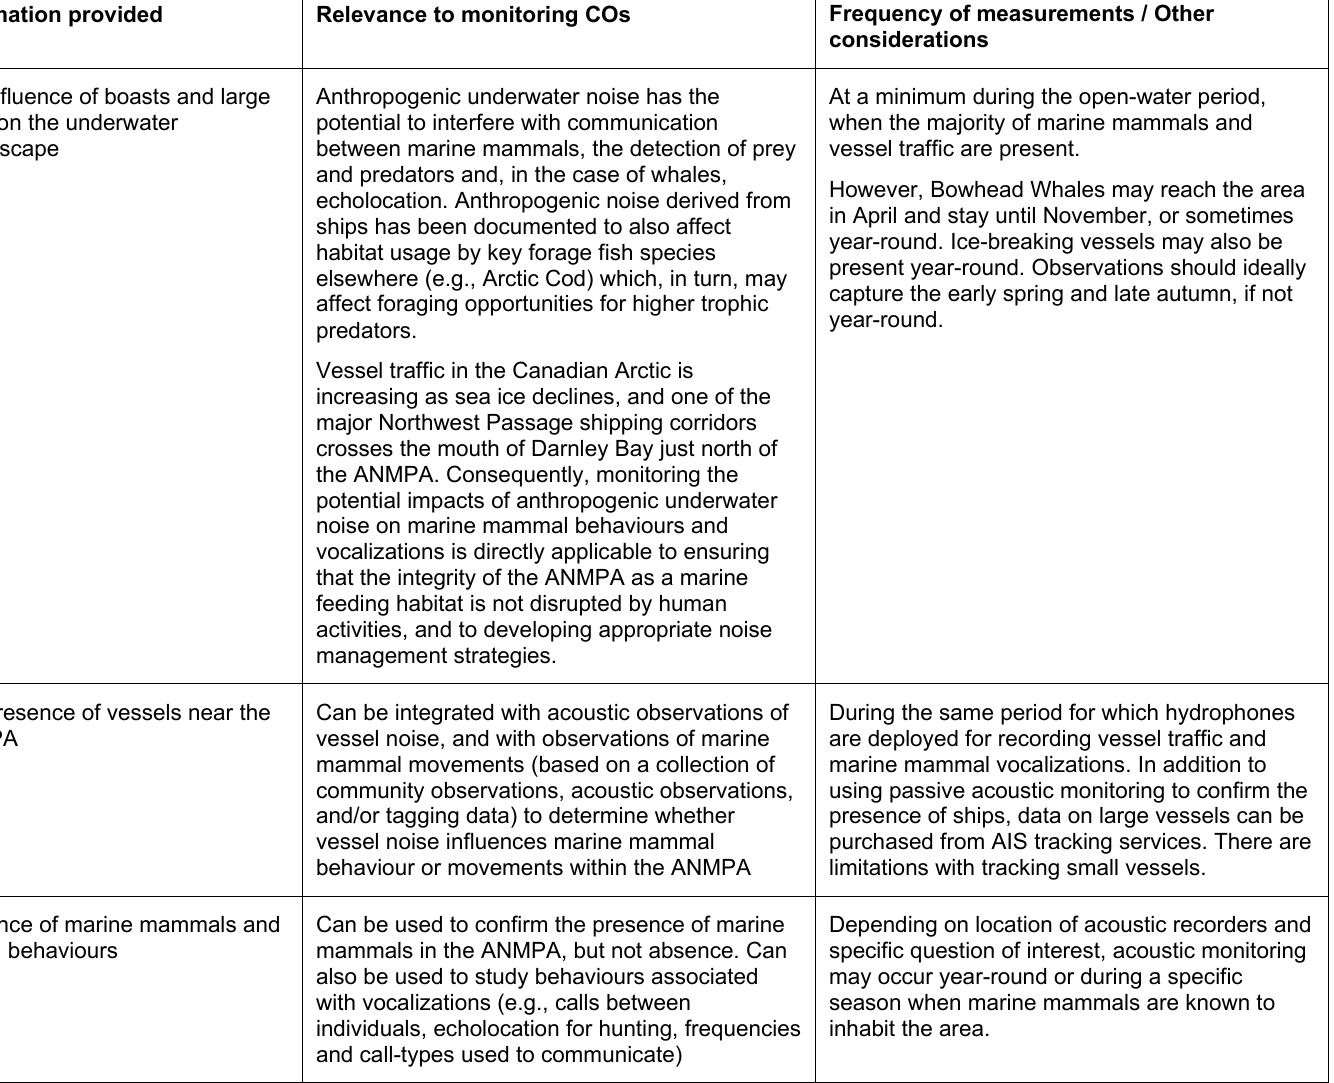
Table C7.1. Key measurement parameters for monitoring anthropogenic underwater noise (Section